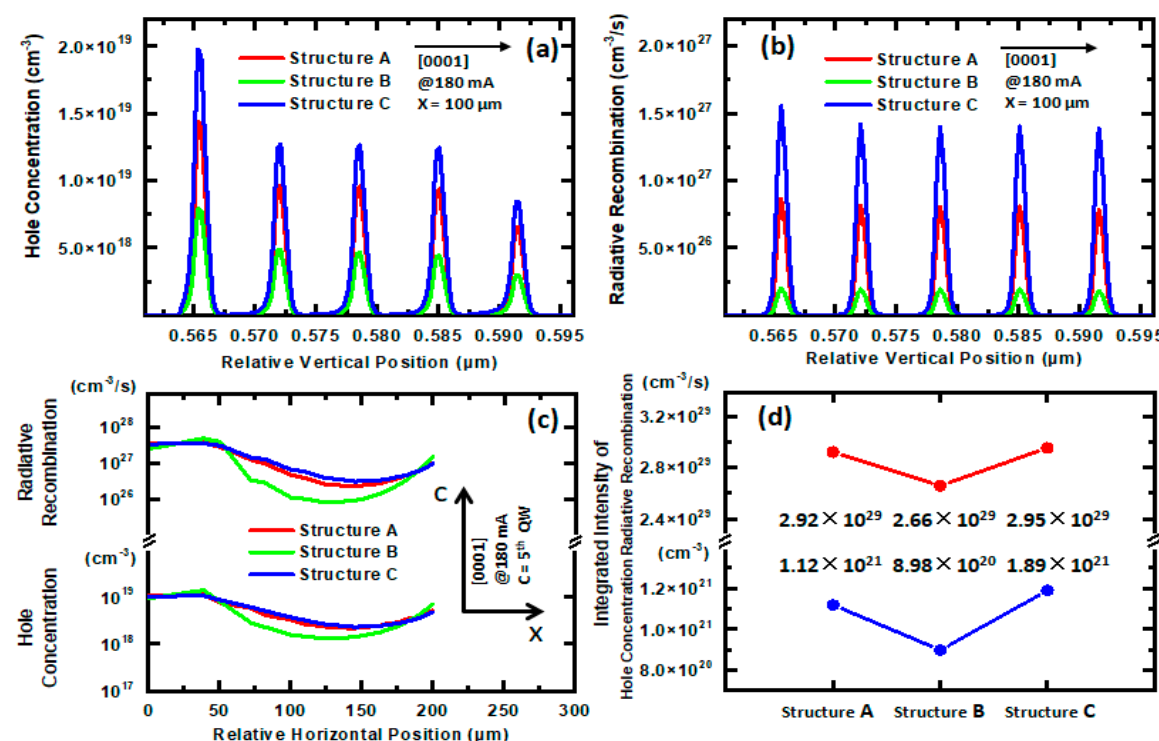
Figure 5. ( a ) Hole concentrations and ( b ) radiative recombination rates in the MQWs. ( c ) Lateral distributions of the hole concentrations and radiative recombination rates along the horizontal direction (x-axis) in MQWs. ( d ) Integrated values of lateral hole concentrations and lateral radiative recombination rates at the relative horizontal positions between 0 and 200 µ m for Structures A, B, and C at a current of 180 mA.